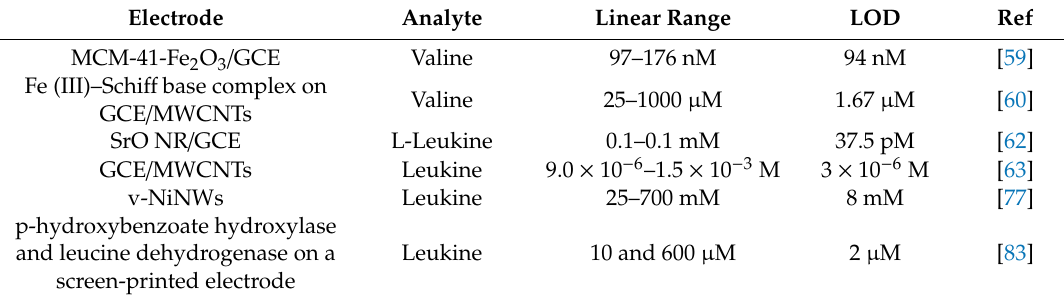
Table 1. Comparison of selected b AA electrochemical